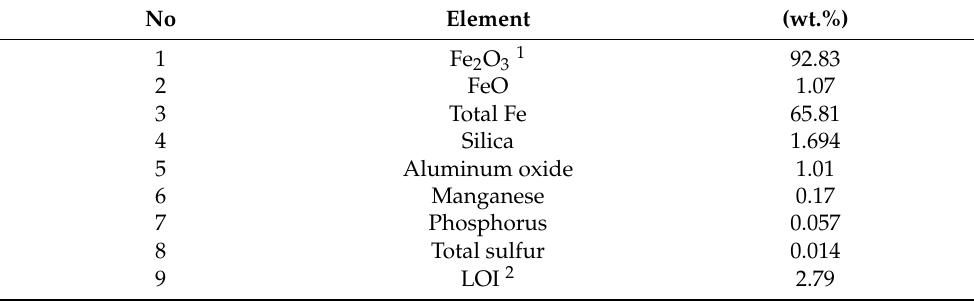
Table 3. Chemical composition of the Carajas iron